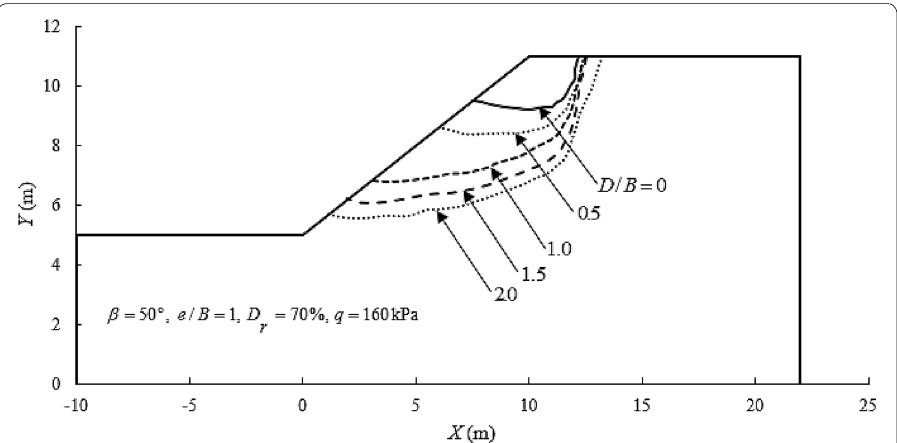
Fig. 12 Slip surface pattern with embedment depth ratio, D /